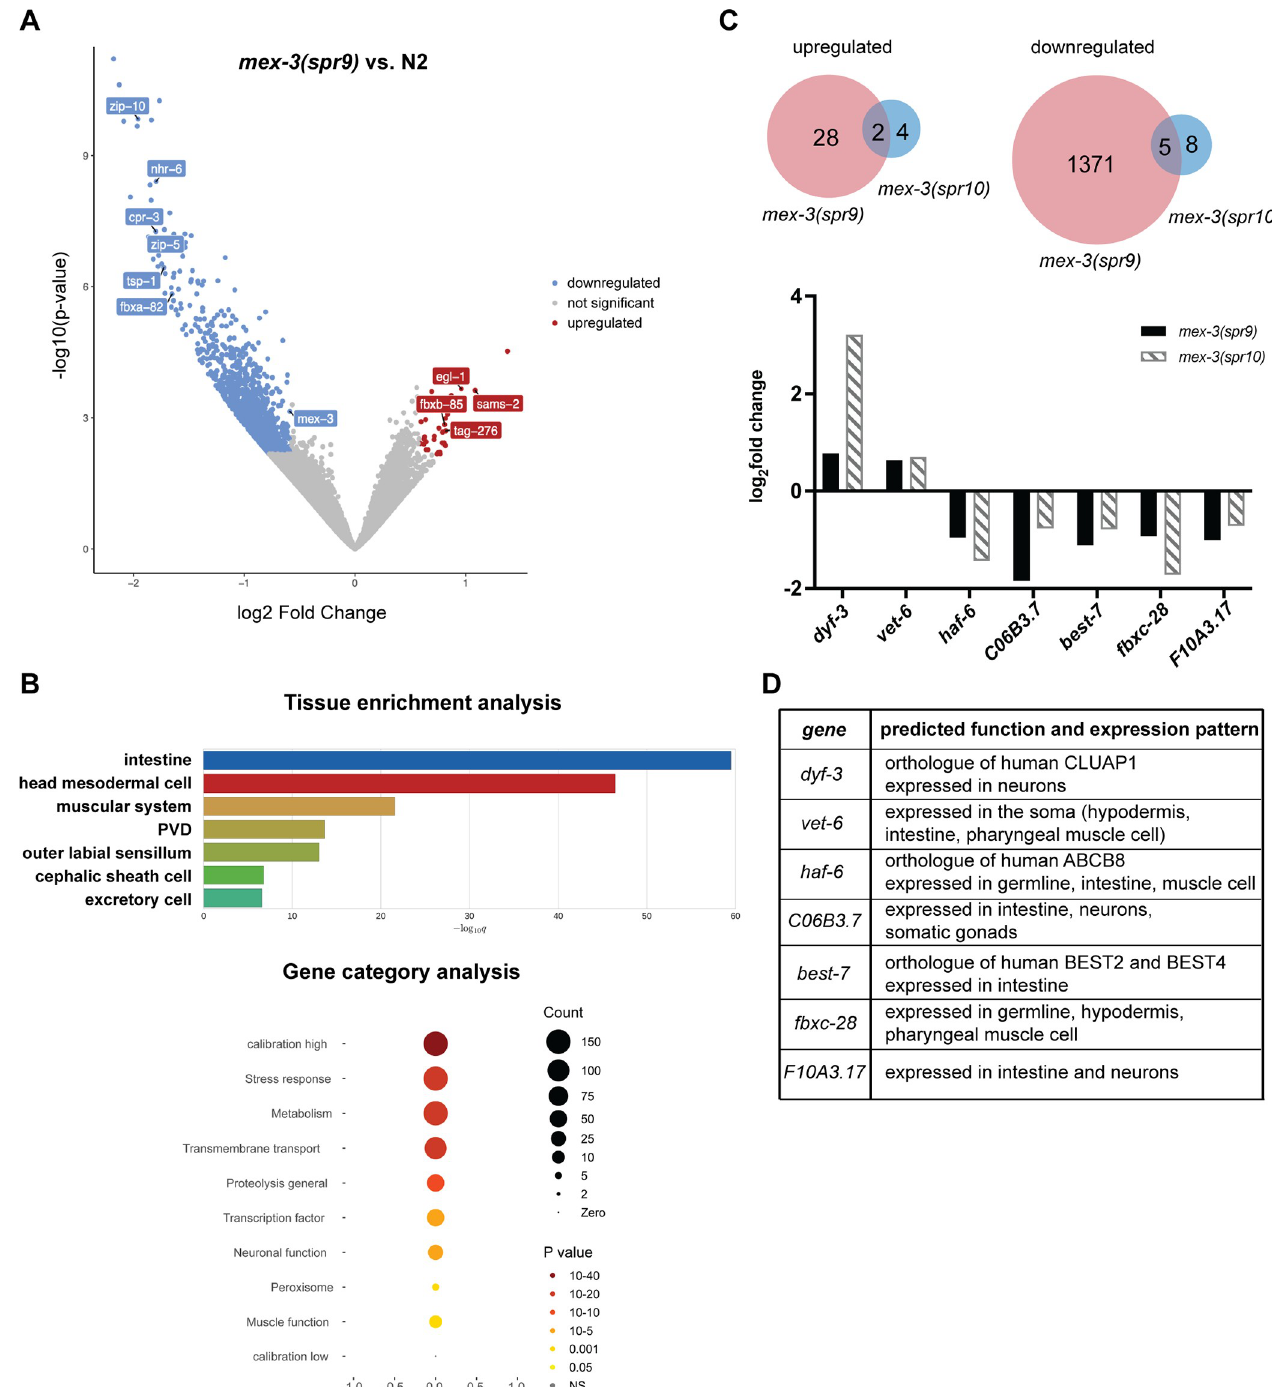
Fig 4. mex-3 3´UTR deletions in mex-3(spr9) and mex-3(spr10) mutants promote expression of somatic genes. (A) volcano plot of genes expressed in the mex-3(spr9) mutant animal. Differentially expressed genes are highlighted in blue (downregulated) or red (upregulated). (B) Tissue enrichment analysis and gene category analysis of the genes differentially expressed in mex-3(spr9) compared to N2. (C) Top: Venn diagrams showing the overlap in the upregulated and downregulated genes in mex-3(spr9) and mex-3(spr10) mutant animals. Bottom: plotted log2 Fold changes of the 7 overlapping genes that are differentially expressed in both mex-3(spr9) and mex-3(spr10) mutant animals. (D) Description of the predicted function and expression pattern of the genes in the graph in panel